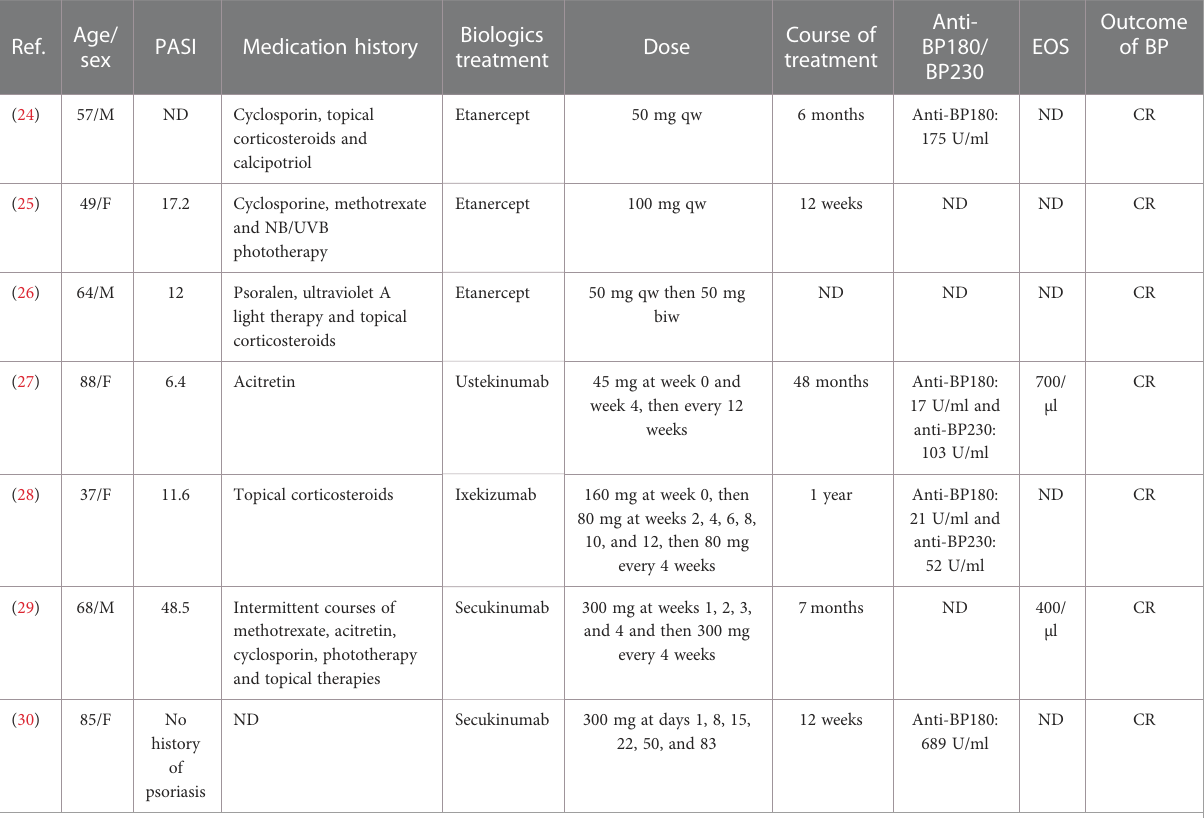
TABLE 3 Clinical characteristics of BP cases treated by biologics.